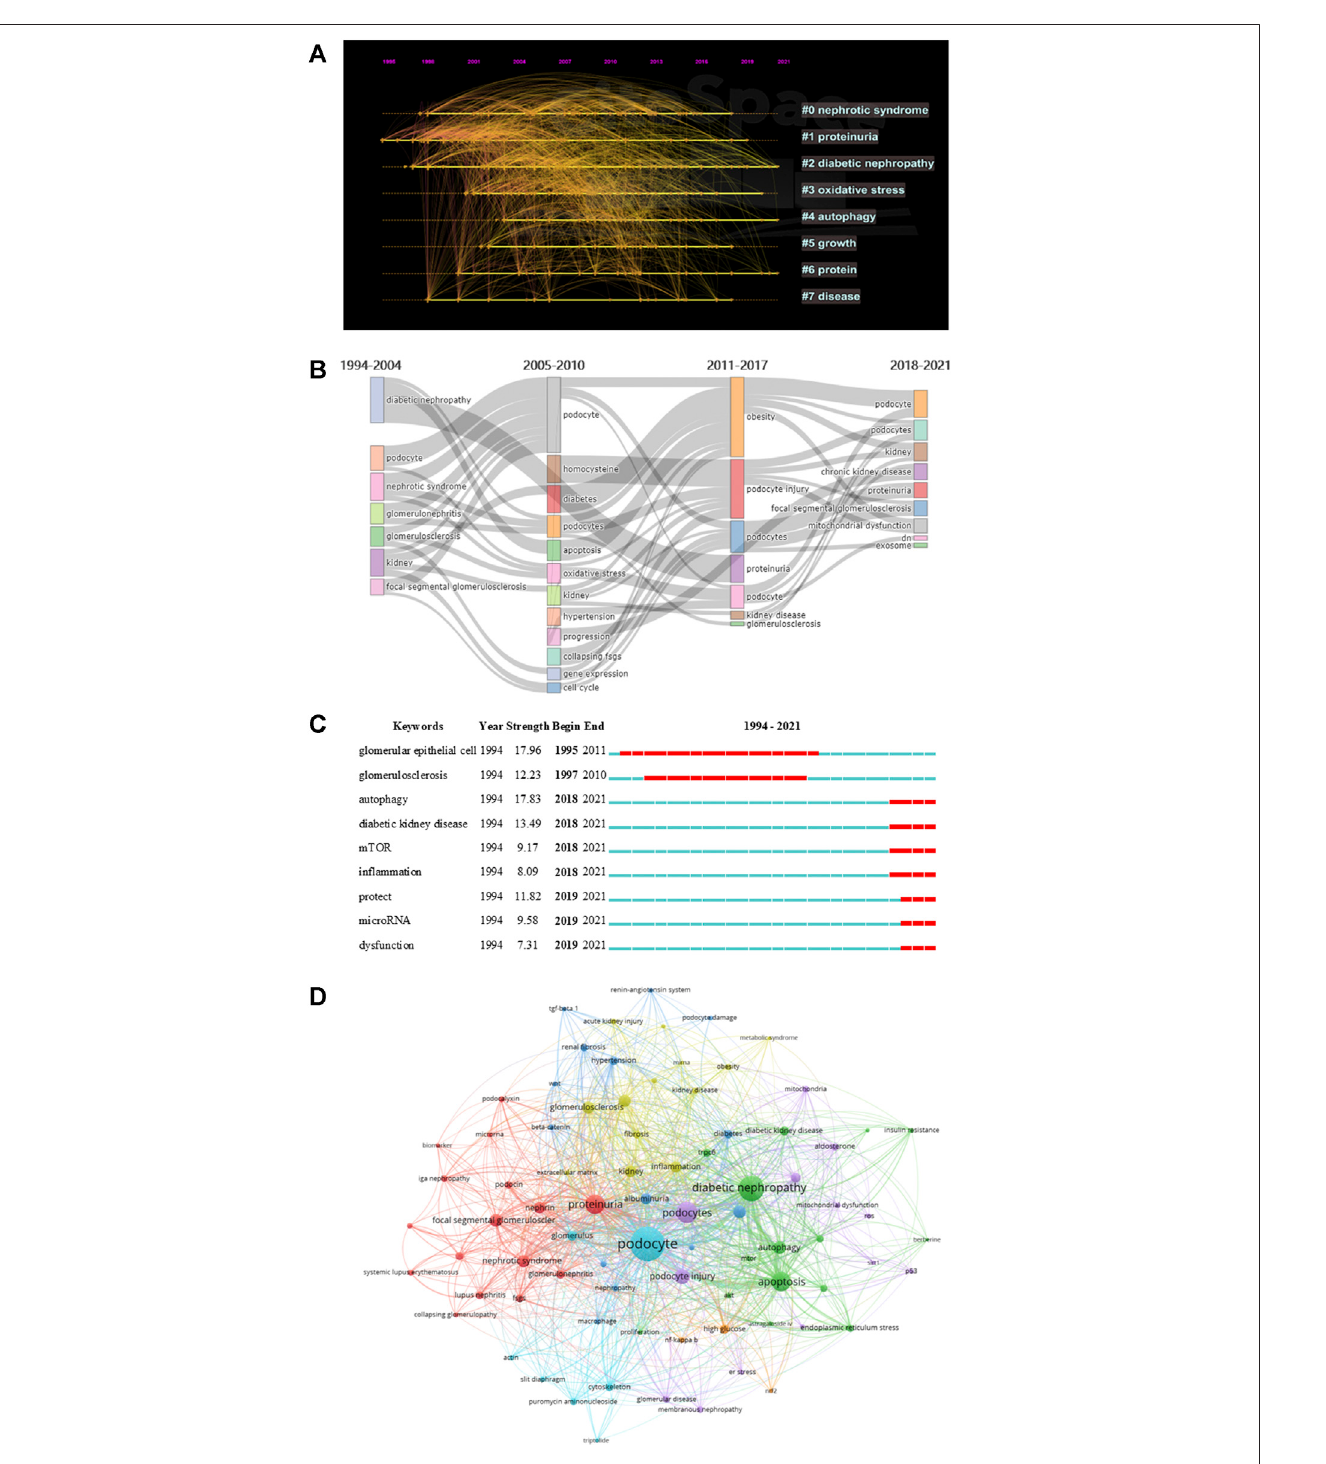
FIGURE 6 | Visualization of keyword analysis. (A) Timeline distribution of cluster analysis of keyword; (B) Sankey diagram of the keywords evolution of podocyte injury research; (C) Representative burst keywords among top 25 references with the strongest citation bursts. (D) The network map of keywords.